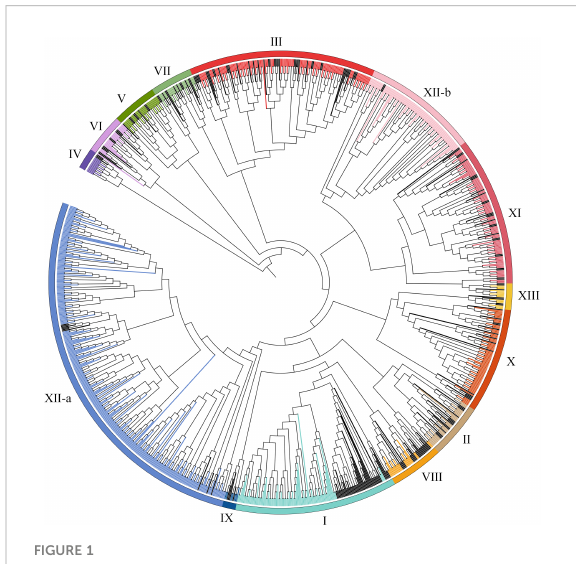
FIGURE 1 Phylogenetic tree for LRR-RLKs identi fi ed in A. thaliana and T. aestivum . The amino acid sequences of LRR-RLK from A. thaliana and T. aestivum were aligned by MEGA 6.0 and the phylogenetic tree was constructed using MEGA 6.0 by the maximum likelihood method with 1000 bootstrap replicates. A total of 929 LRR-RLK genes were classi fi ed into 14 groups (I-XI, XII-a, XII-b, XIII) and are highlighted by different colors. LRR-RLKs from A. thaliana in each subfamily were highlighted by